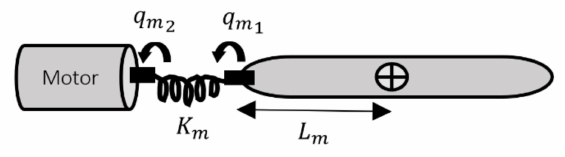
Figure 2. Flexible-joint mechanism.